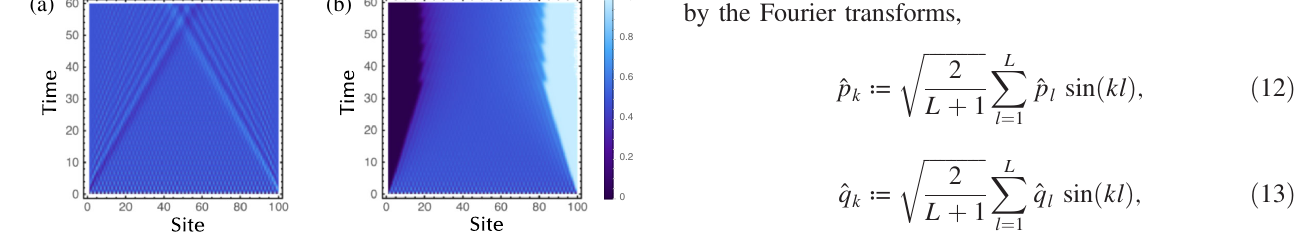
FIG. 2. Time evolution of the local particle number n l ð t Þ ≔ h ψ ð t Þj ˆ n l j ψ ð t Þi in the Hatano-Nelson model with open boundaries ( L ¼ 100 , J ¼ 1 . 0 ) for (a) γ ¼ 0 . 0 and (b) γ ¼ 0 . 8 . The initial state is prepared as the charge density wave state in Eq. (4). In the presence of non-Hermiticity, particles accumulate at the boundary, which is a clear signature of the non-Hermitian skin